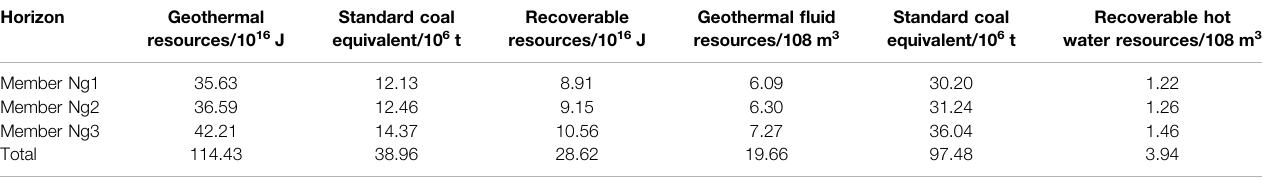
TABLE 2 | Statistics on geothermal resources of Guantao Formation (Ng1 – 3) in Caofeidian geothermal fi eld. Horizon